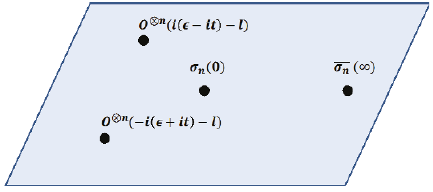
Figure 2 . The positions of operators in the replica computation